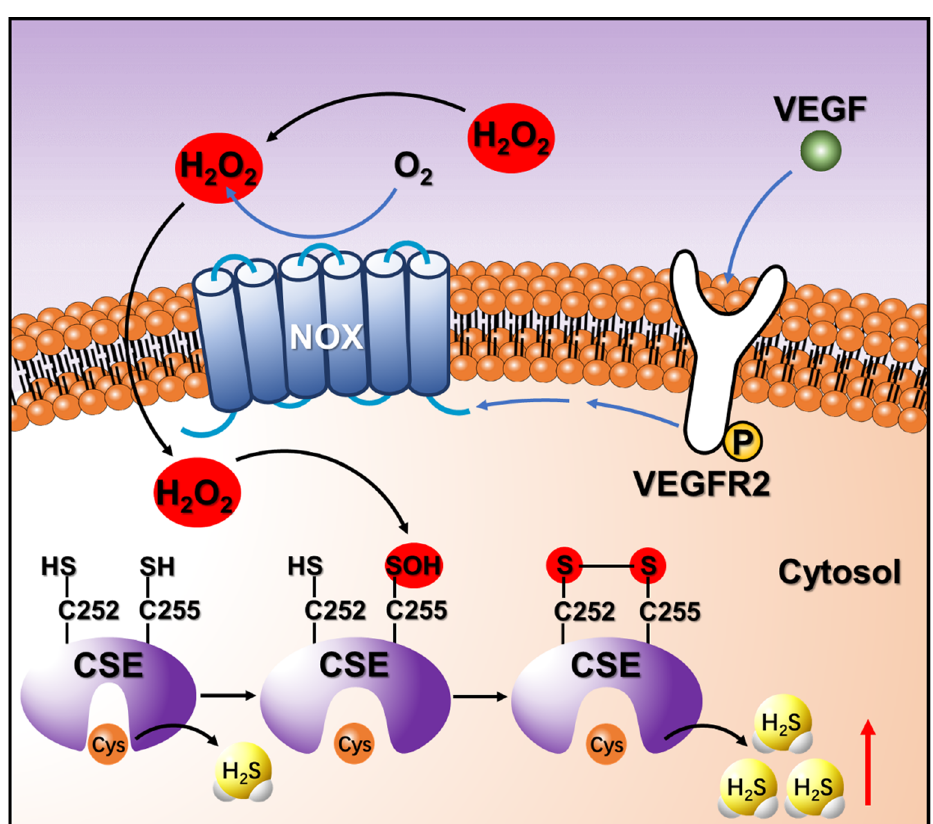
Figure 6. Schematic of the regulatory mechanism of CSE and H 2 O 2 /H 2 S crosstalk in HA-VSMCs stimulated with exogenous H 2 O 2 or VEGF. VEGF stimulates the VEGFR2 receptor, which is auto- phosphorylated and activates NOX to generate endogenous H 2 O 2 . Exogenous H 2 O 2 or endogenous H 2 O 2 triggered by VEGF oxidizes the thiol group of Cys255 to the sulfenic acid, which stimulates the activity of CSE, thus leading to the enhancement of H 2 S production. The unstable sulfenic acid of Cys255 reacts quickly with the thiol of the vicinal Cys252 to form the stable disulfide